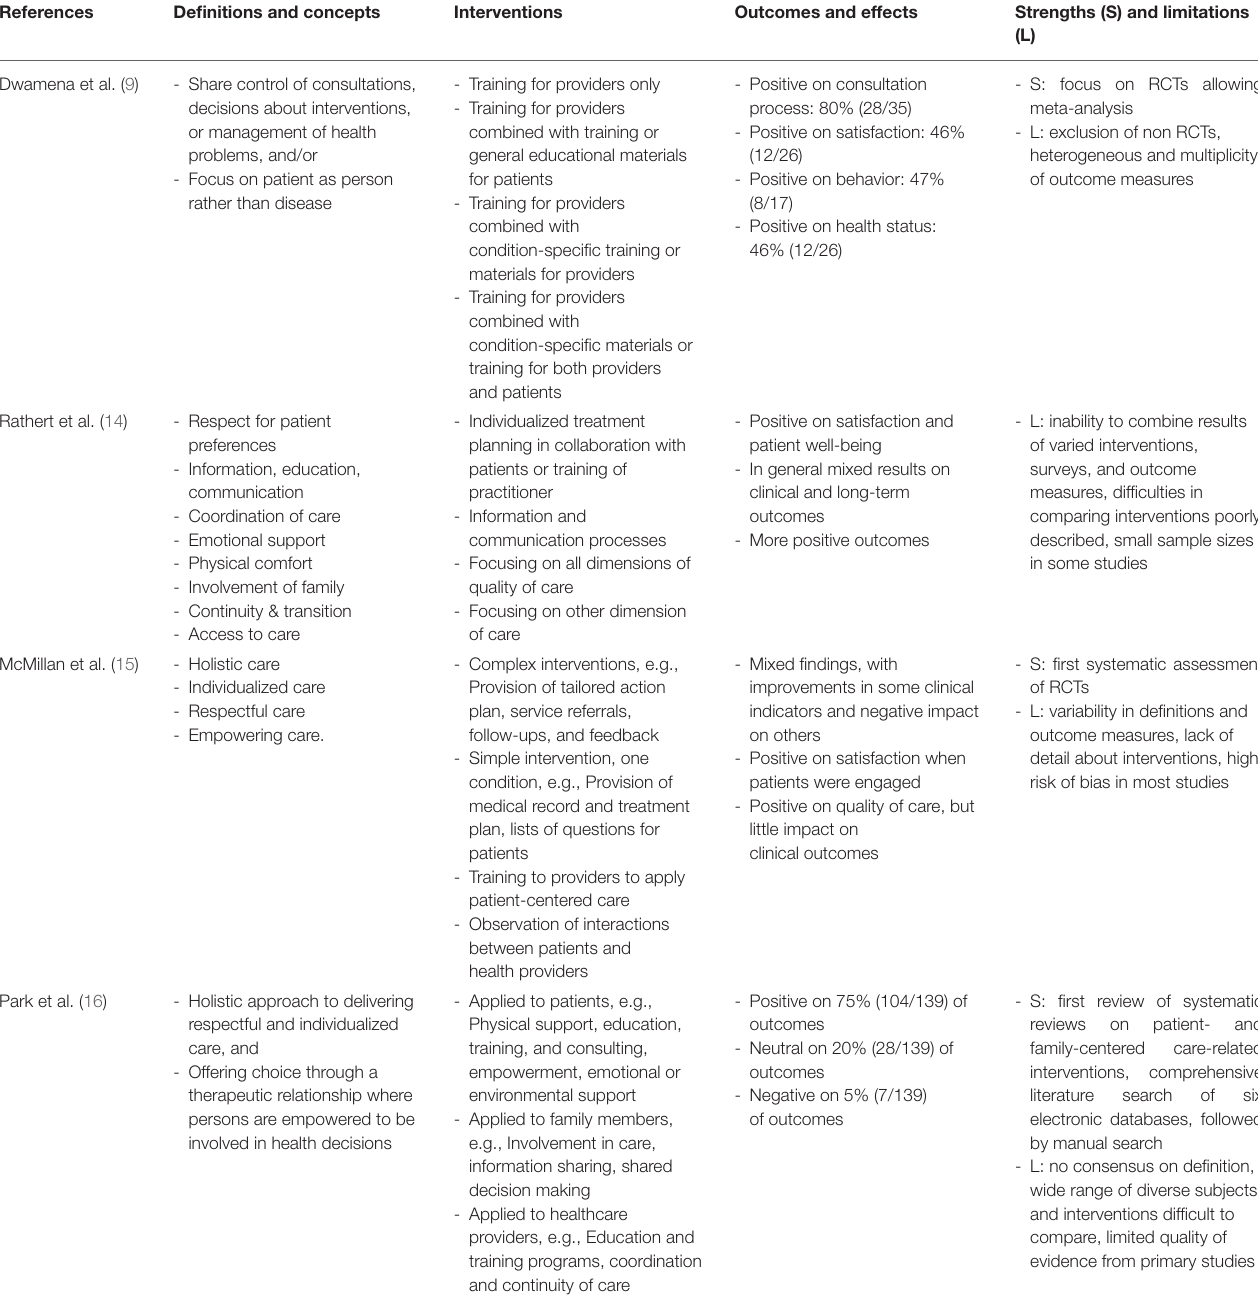
TABLE 2 | Overview of definitions, interventions, outcomes and effects, and strengths and